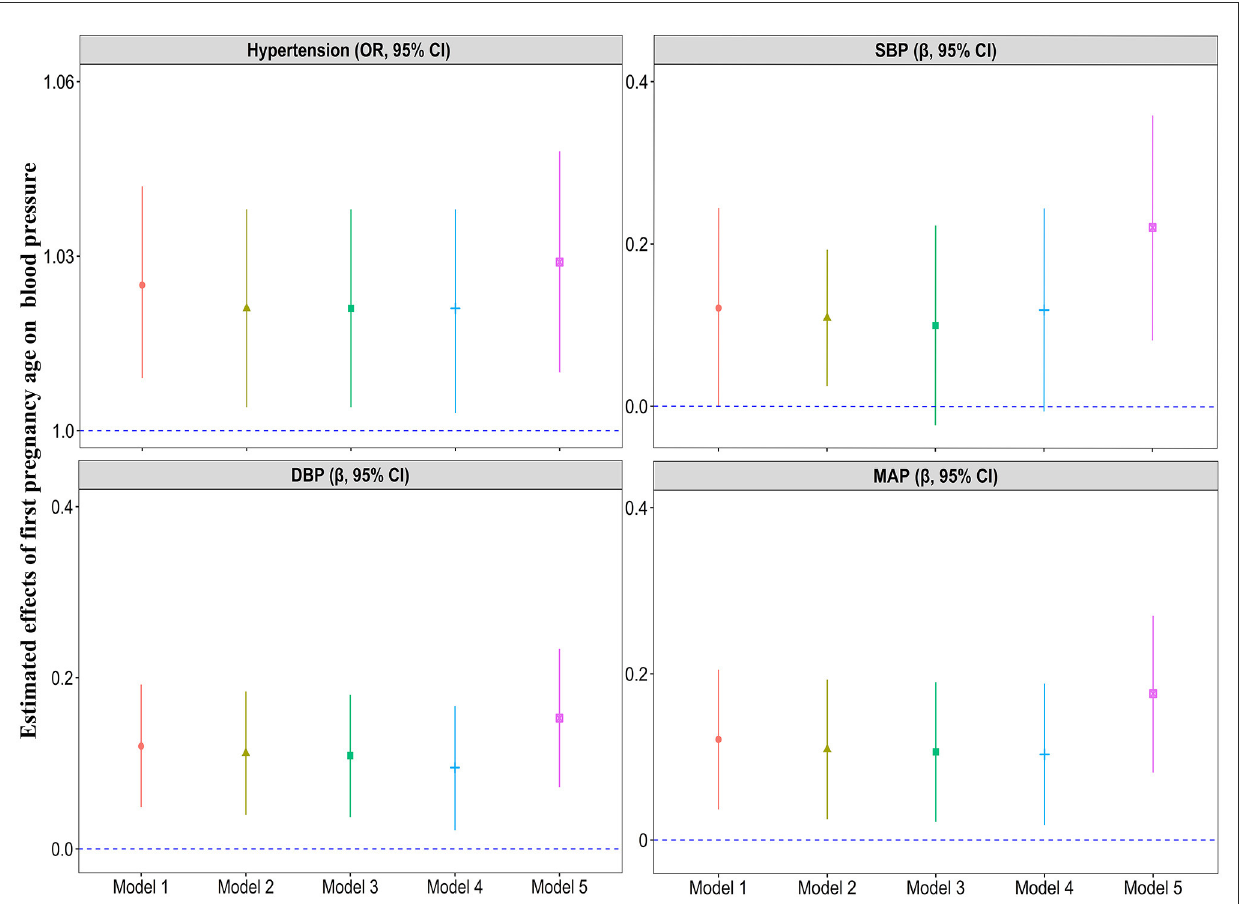
FIGURE1 Multivariable analysis of first pregnancy age with hypertension, SBP, DBP, and MAP. Model 1: adjusted for age, marital status, education level, family per capita yearly income, smoking, alcohol consumption, physical activity, adequate intake of vegetables and fruits, high-fat diet, family history of hypertension, and BMI; Model 2: adjusted as in model 1 plus age at menarche, menopause status, breastfeeding, and use of oral contraceptive pills; Model 3: adjusted as in model 2 plus gestational hypertension and gestational diabetes mellitus; Model 4: adjusted as in model 3 plus parity; Model 5: adjusted as in model 4 plus age at last